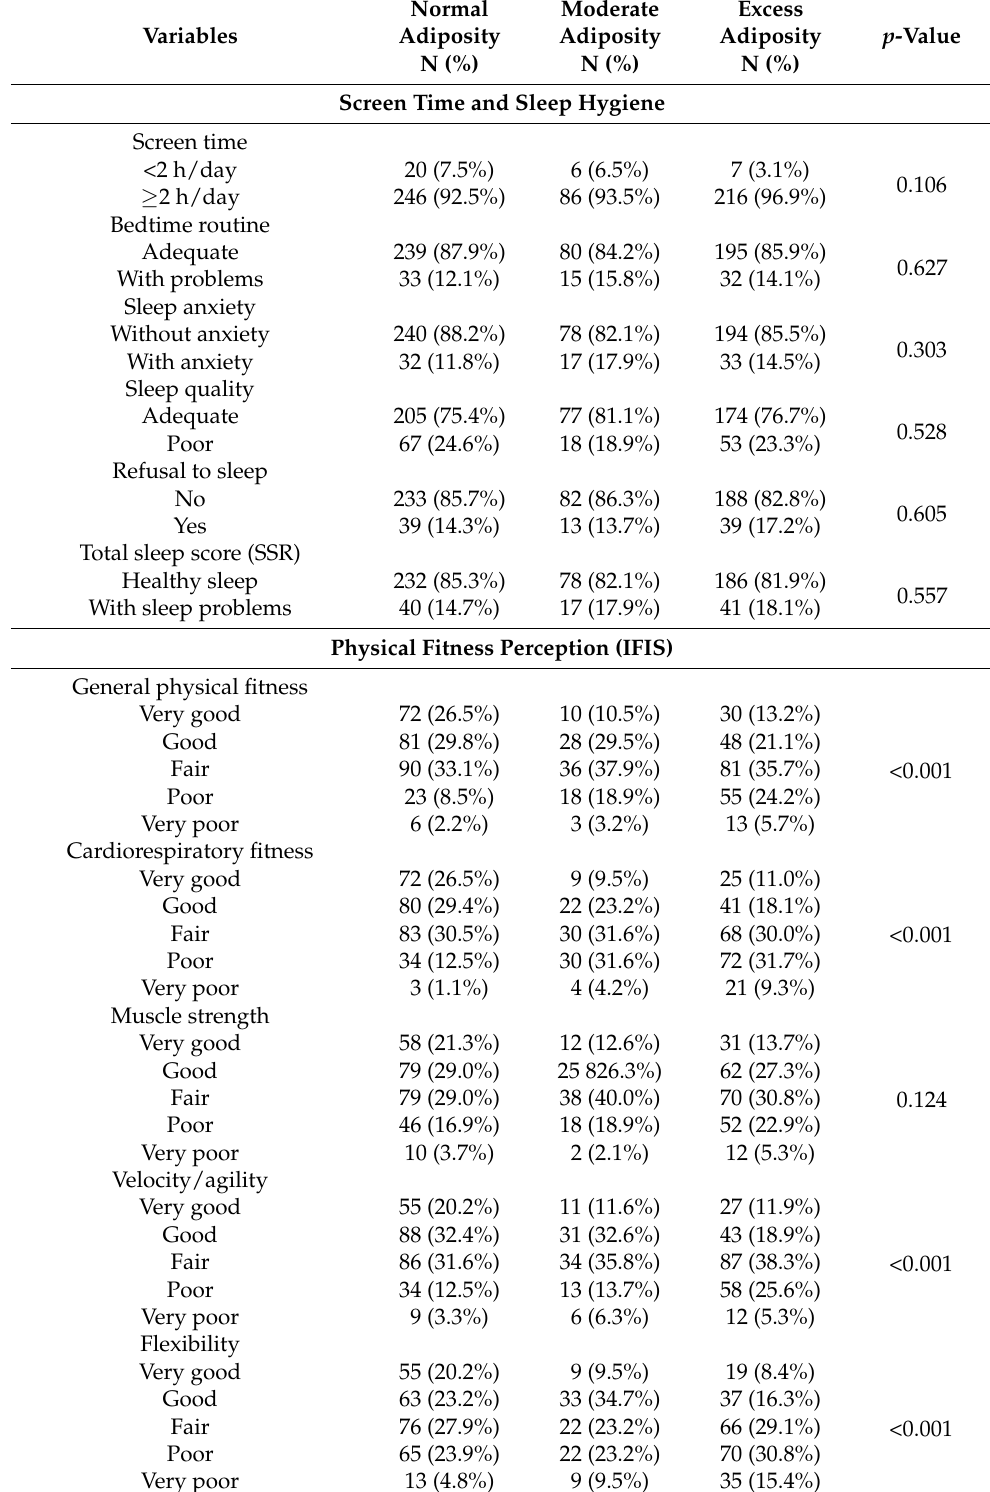
Table 2. Screen time, bedtime routine, and physical fitness